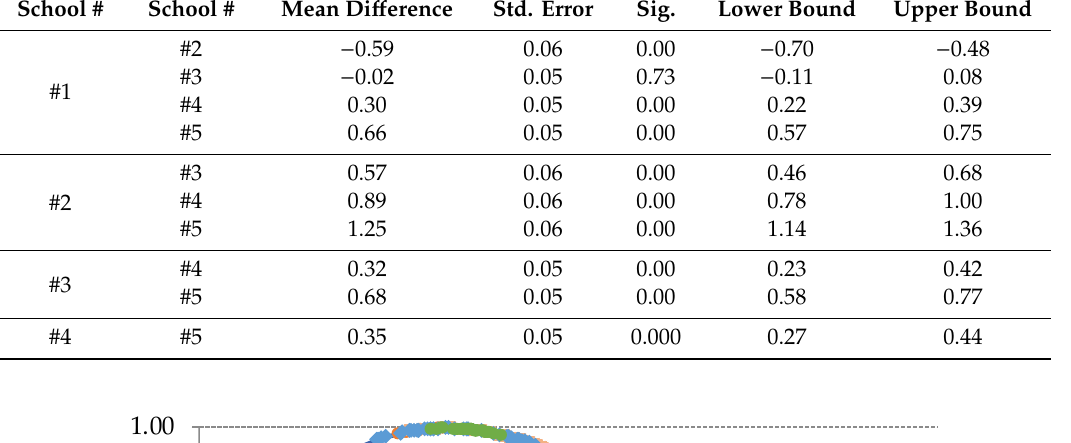
Table 8. Fishers LSD Analysis for Classroom Temperature by School.